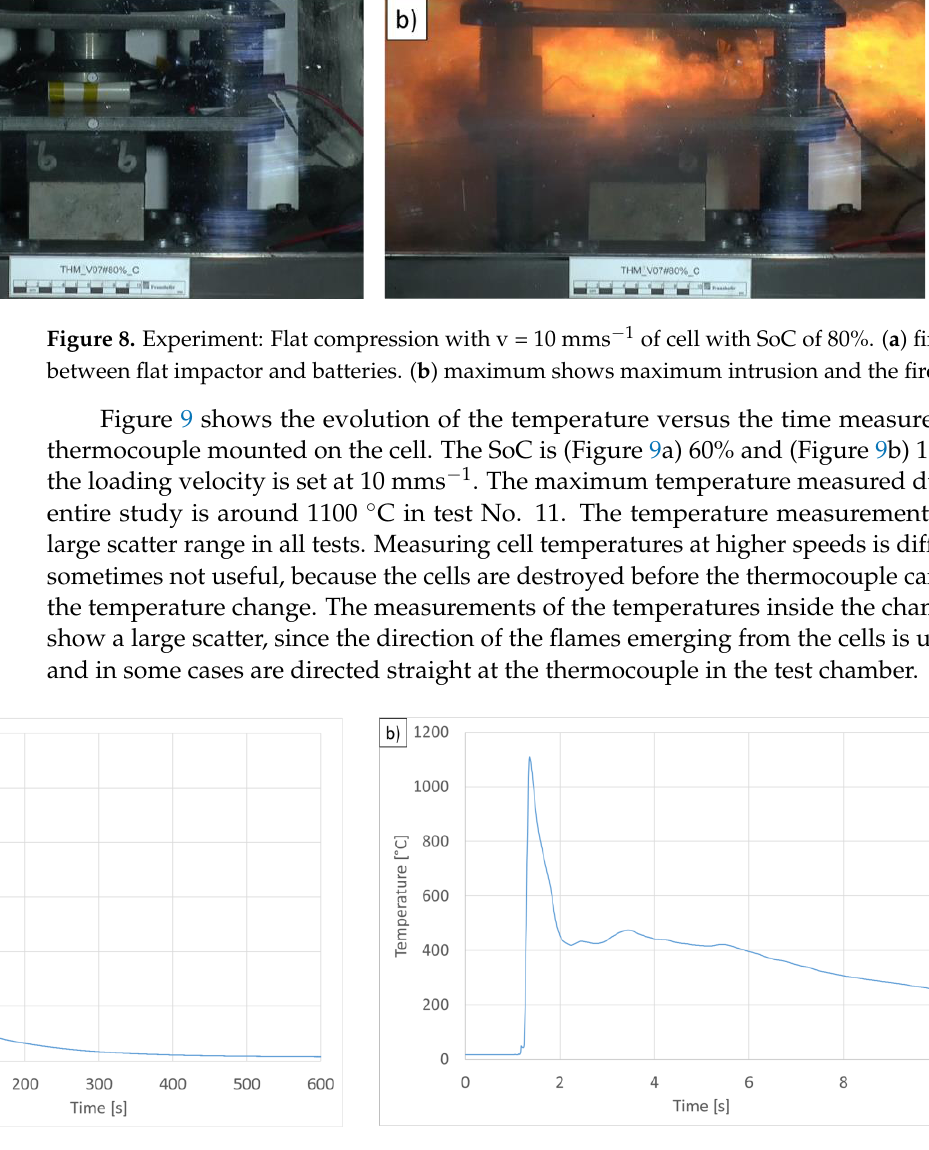
Figure 9. Measured temperature vs. time of the cell test ( a ) no 4 with a SOC of 60% and ( b ) No. 11 with a SoC of 100%.